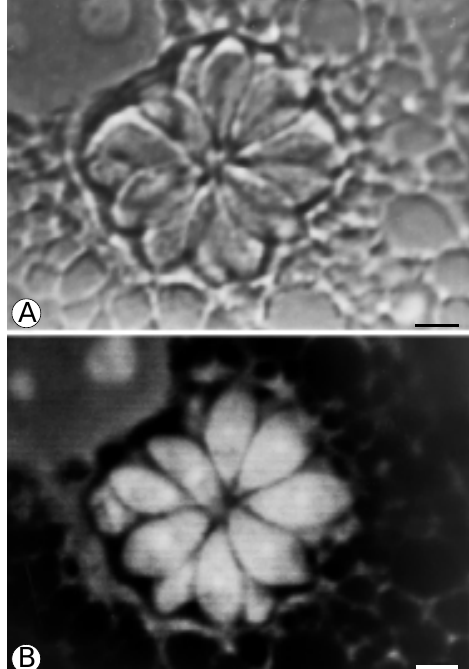
Figure 9 - Localization of mitochondria, using rhodamine 123, in cells infected with Trypan- osoma cruzi for 48 h. Bar = 25 µm. A, Interference contrast microscopy; B,